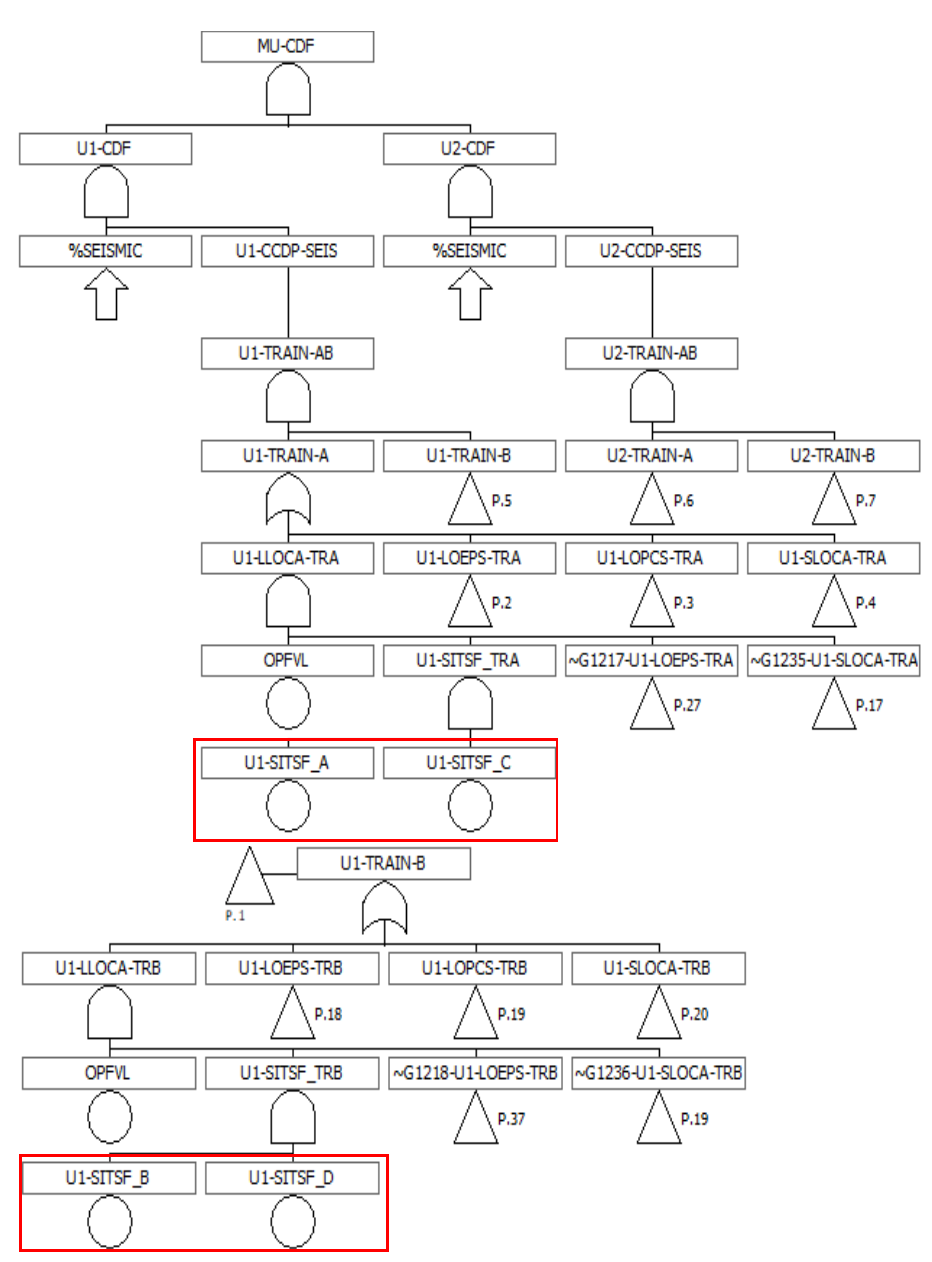
Figure 10. MUCDF fault tree (Model A).